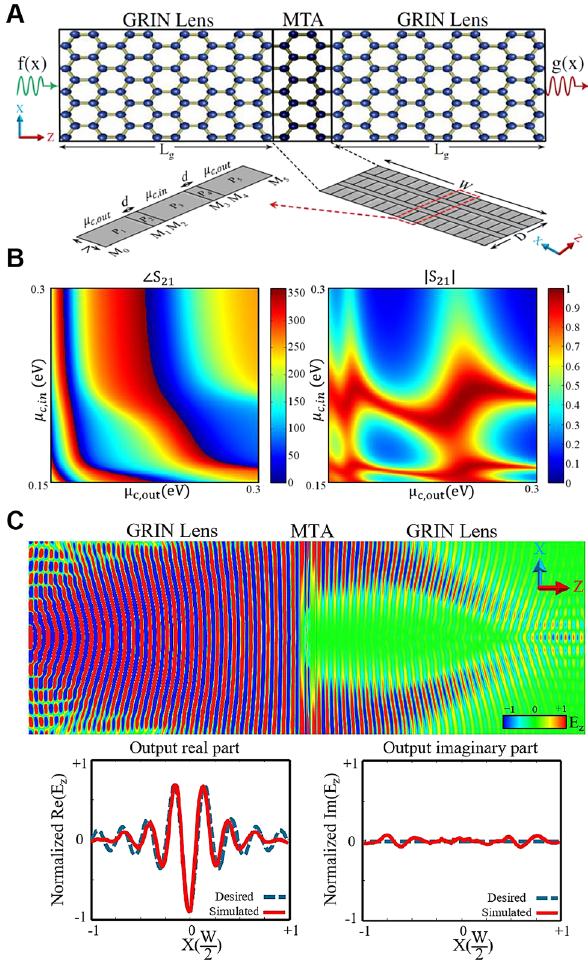
Figure 4: Linear transversely invariant graphene-based metastructure to perform mathematical operations